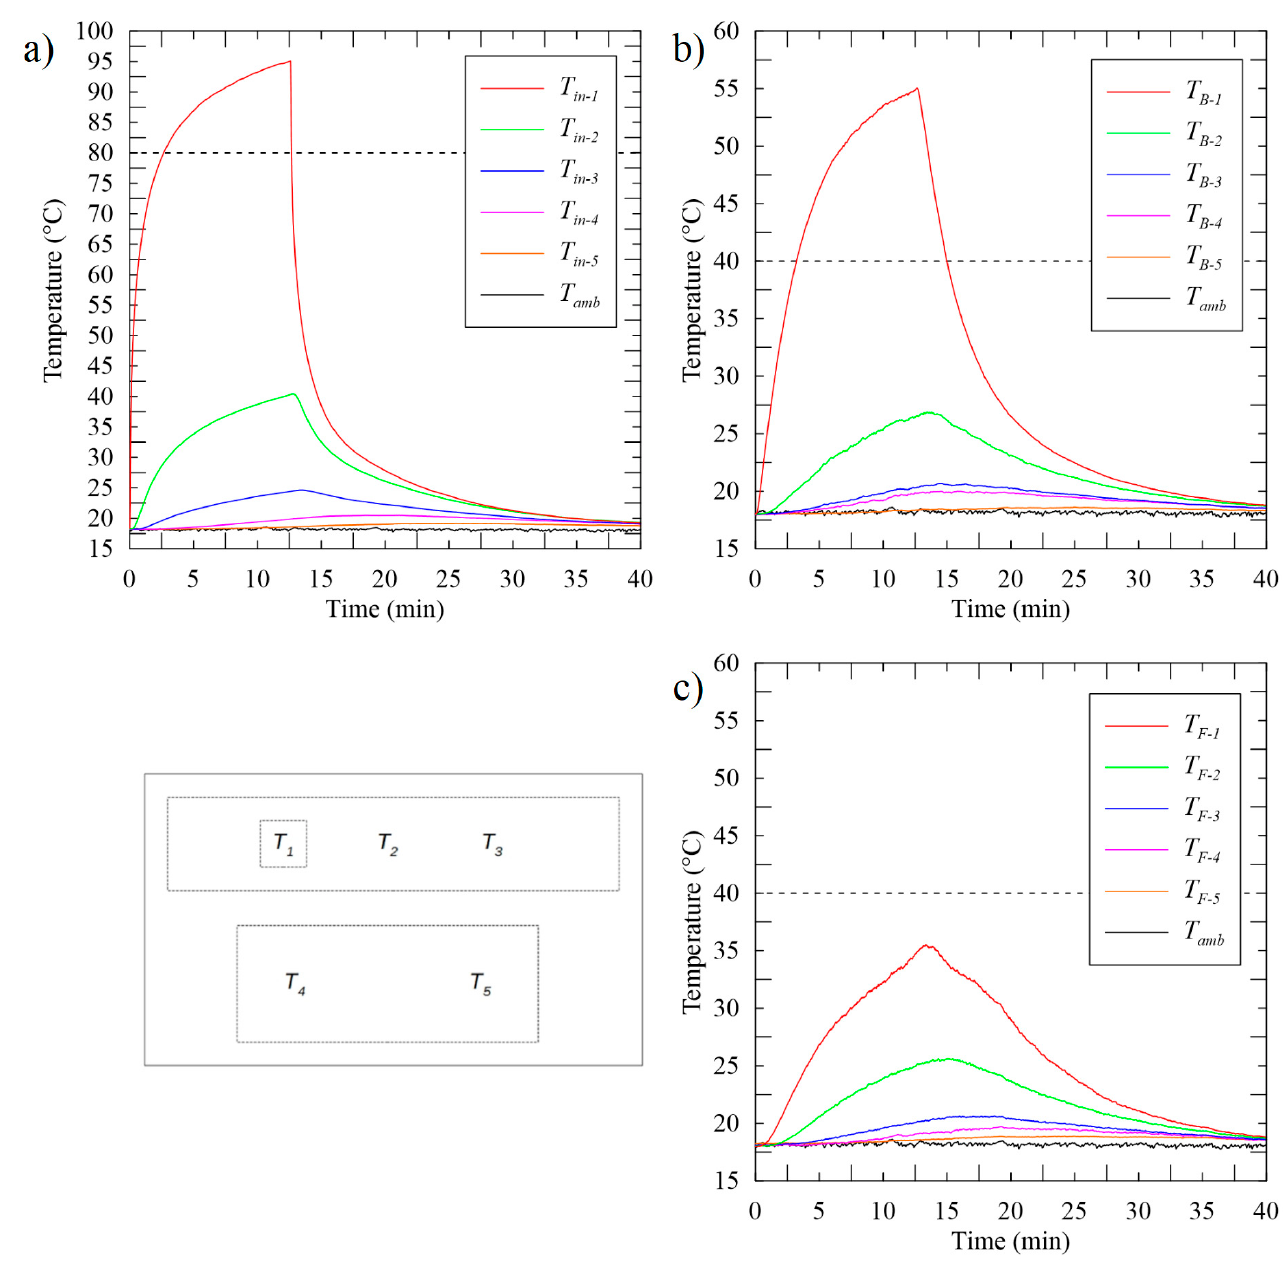
Figure 5. Temperature measurements on the ( a ) inside, ( b ) back cover, and ( c ) display of the mock tablet with no temperature control solution installed and a heat generation rate of 4.5 W (the dashed line represents the relevant temperature limit).